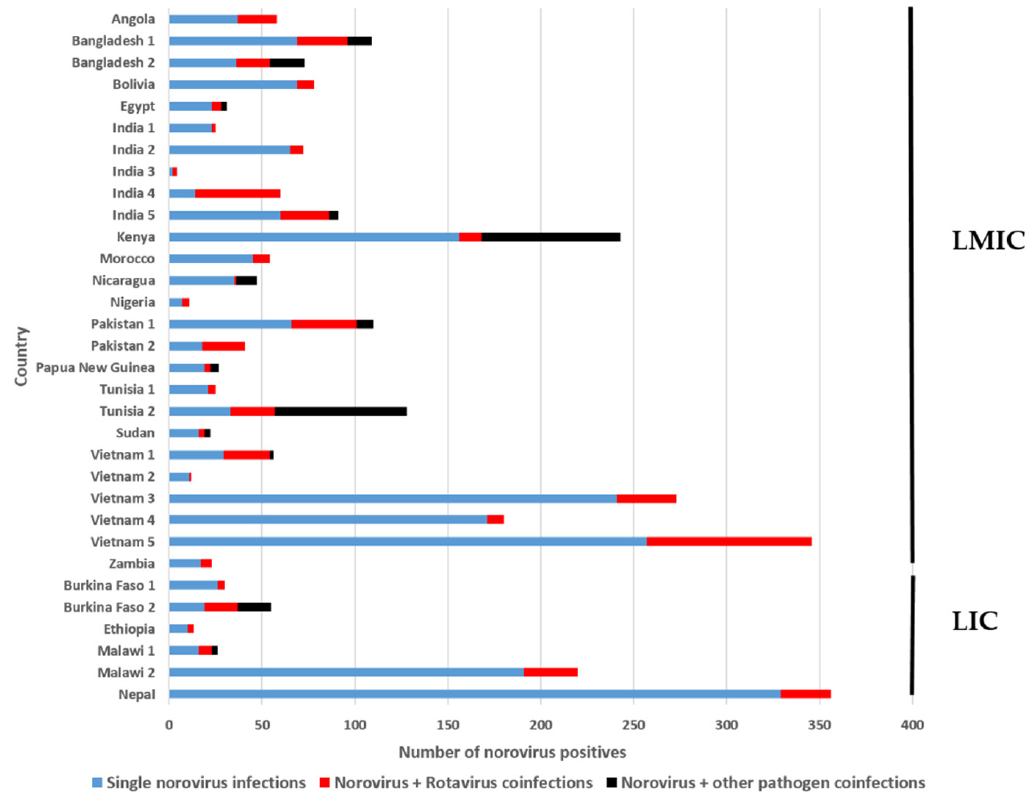
Figure 3. An overview of the norovirus coinfections from 26 studies in 15 LMIC countries and six studies in four LIC countries: Twelve studies tested for norovirus and rotavirus; 12 studies tested for a range of enteric viruses; five studies tested for viruses and bacteria; and three studies tested for viruses, bacteria, and parasites.